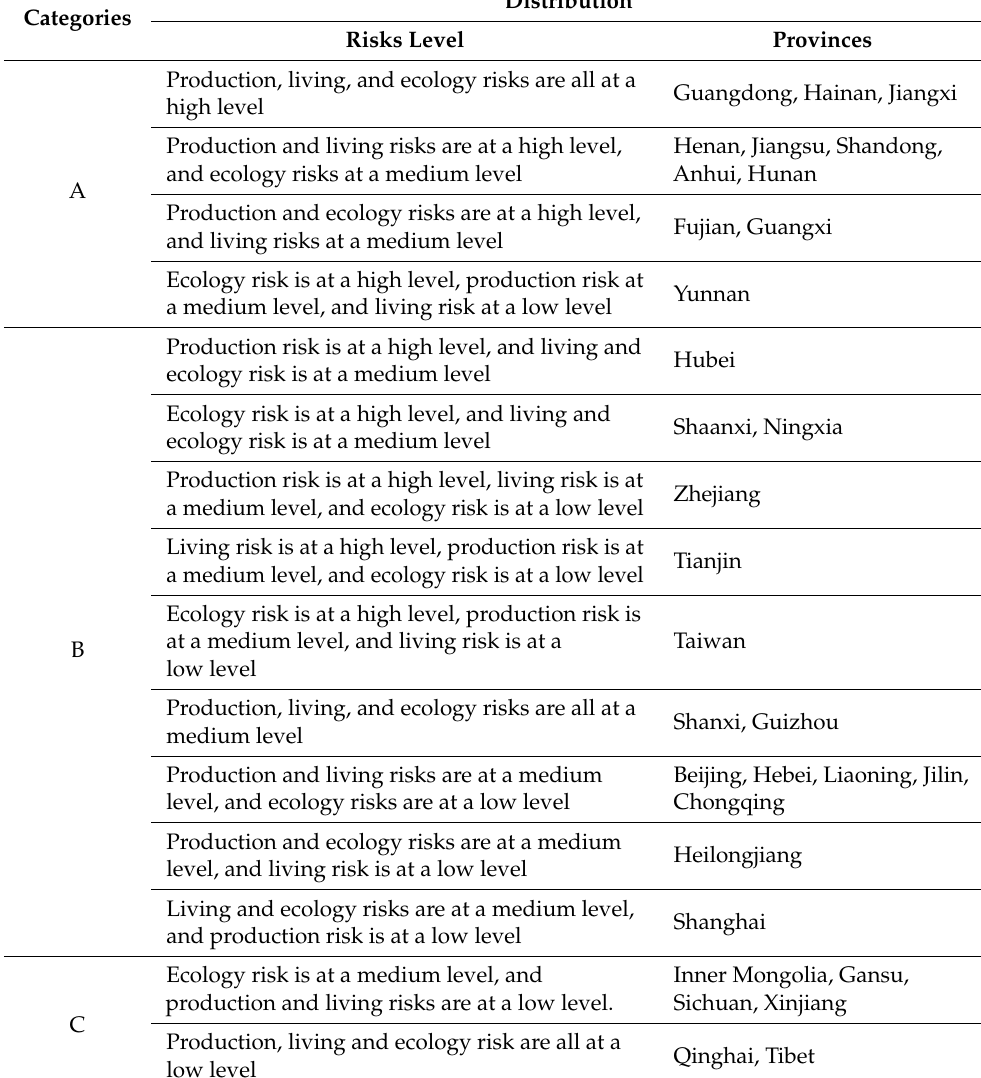
Table 2. Statistical analysis within the categories to cope with production, living, and ecology